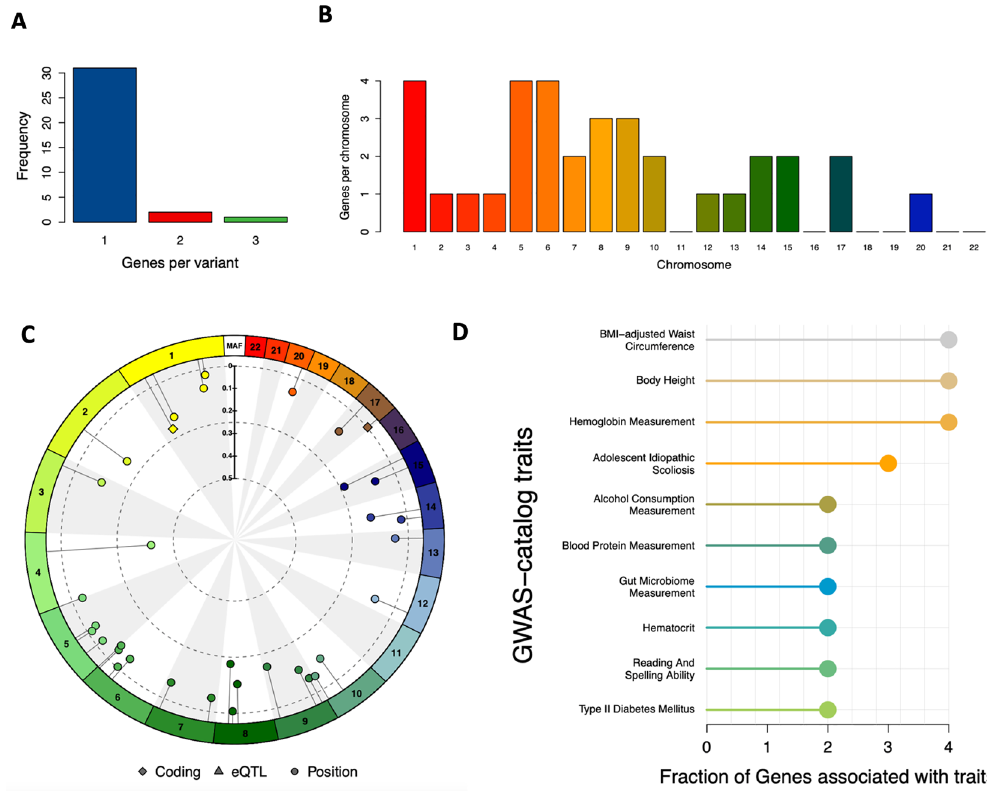
Figure 3. Results of the functional annotation of the 34 independent SNPs (single nucleotide polymorphisms) associated with different lipid species of human plasma lipidome.( A ) Number of genes associated with each of the 34 independent SNPs.( B ) Chromosomal distribution of all the 34 SNPs. ( C ) Circular summary figure showing the type of annotation of each SNP (coding, eQTL or annotated by their positions) as well as each SNP’s minor allele frequency and chromosomal distribution.( D ) Number of genes associated with the 34 independent SNPs (single nucleotide polymorphisms), expressed as fraction, for which a previous association was reported in the GWAS-catalog version 1.0.2 downloaded from https:// www. ebi. ac. uk/ gwas/ docs/ file- downl